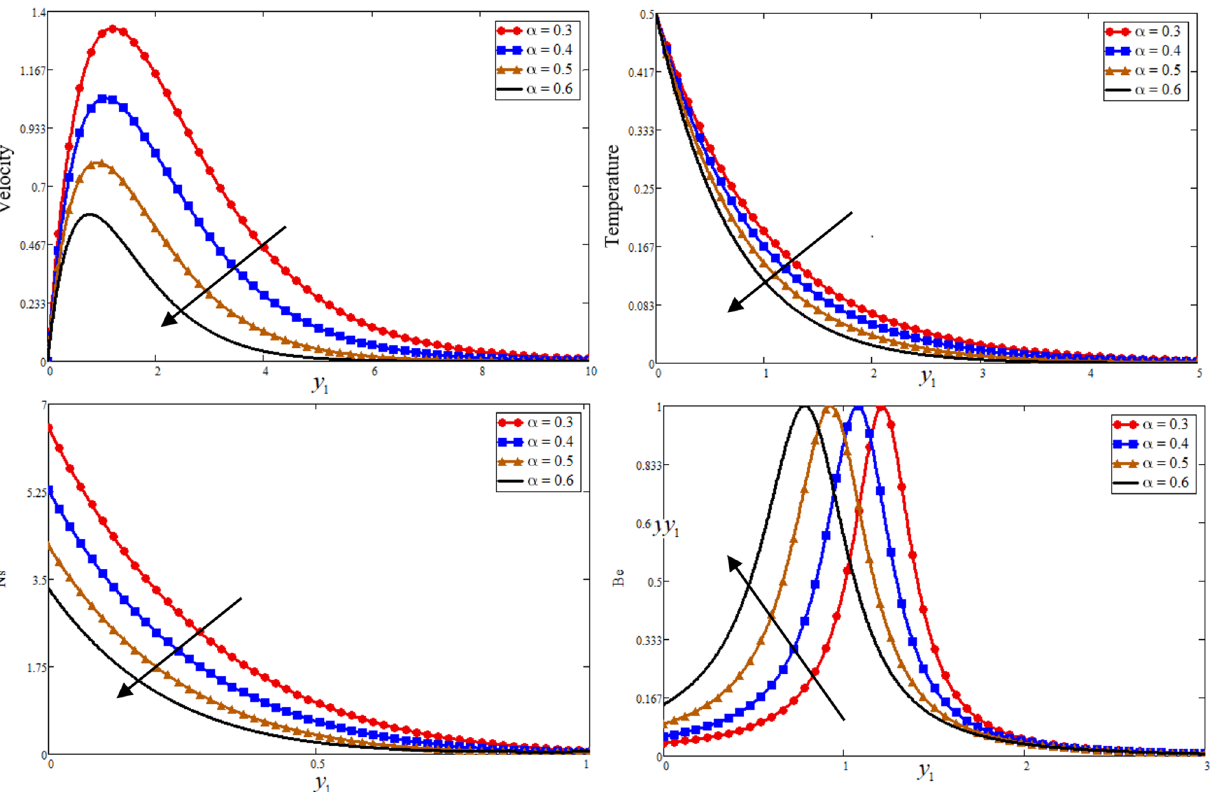
Figure 1. Effect of α Bejan number, entropy generation, temperature, and